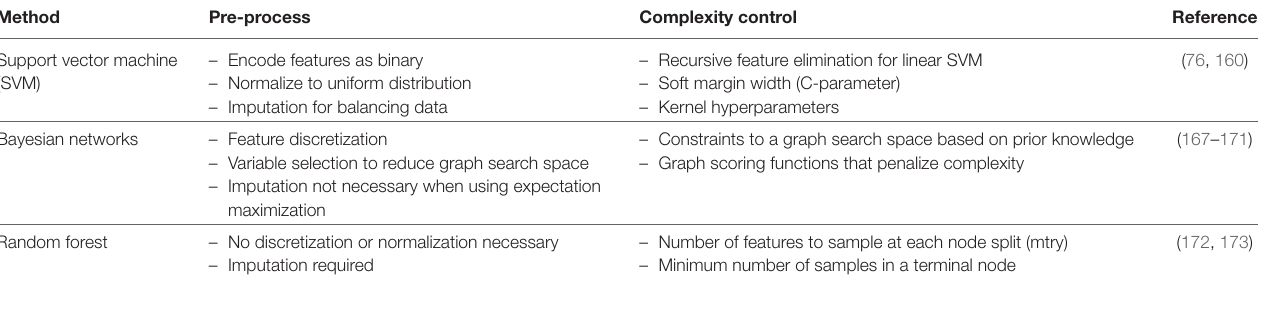
TABLe 1 | Three representative machine learning methods with select pre-processing tips and tuning methods for complexity